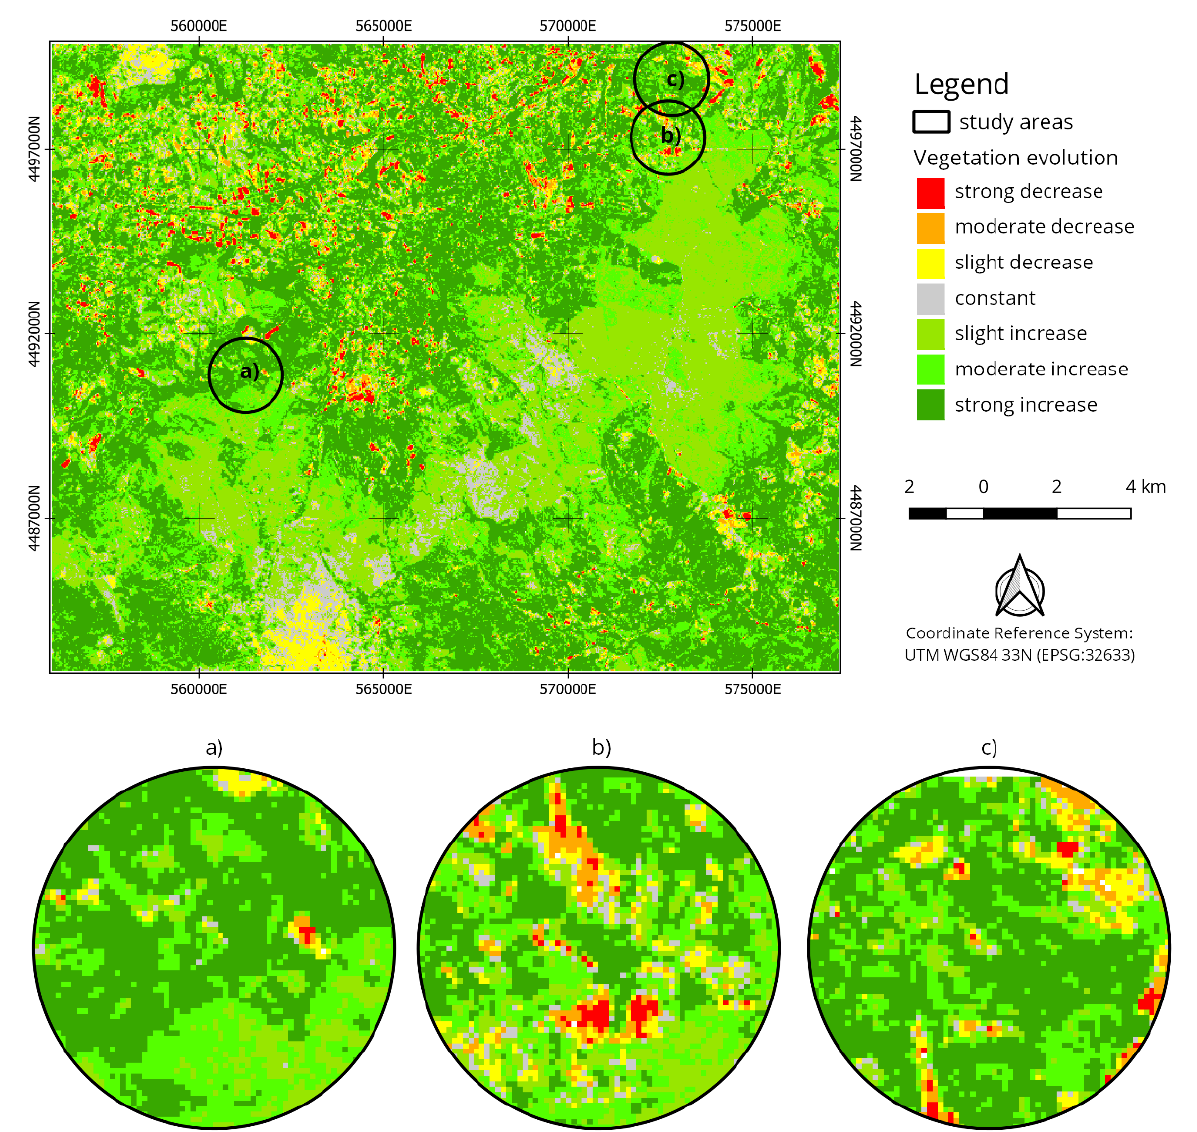
Figure 5. Map of the vegetation evolution of the whole study area and related detail maps of the three sites of interest: ( a ) Aia dei Monaci, ( b ) Montegrosso-Pallareta, ( c ) Vallone Calabrese. For the survey sites, consisting of circular areas with a radius of 1 km, the distribu- tion percentages of the vegetation evolution classes are shown in Table 3. Table 3. Percentage distribution of the vegetation evolution classes in the survey sites.